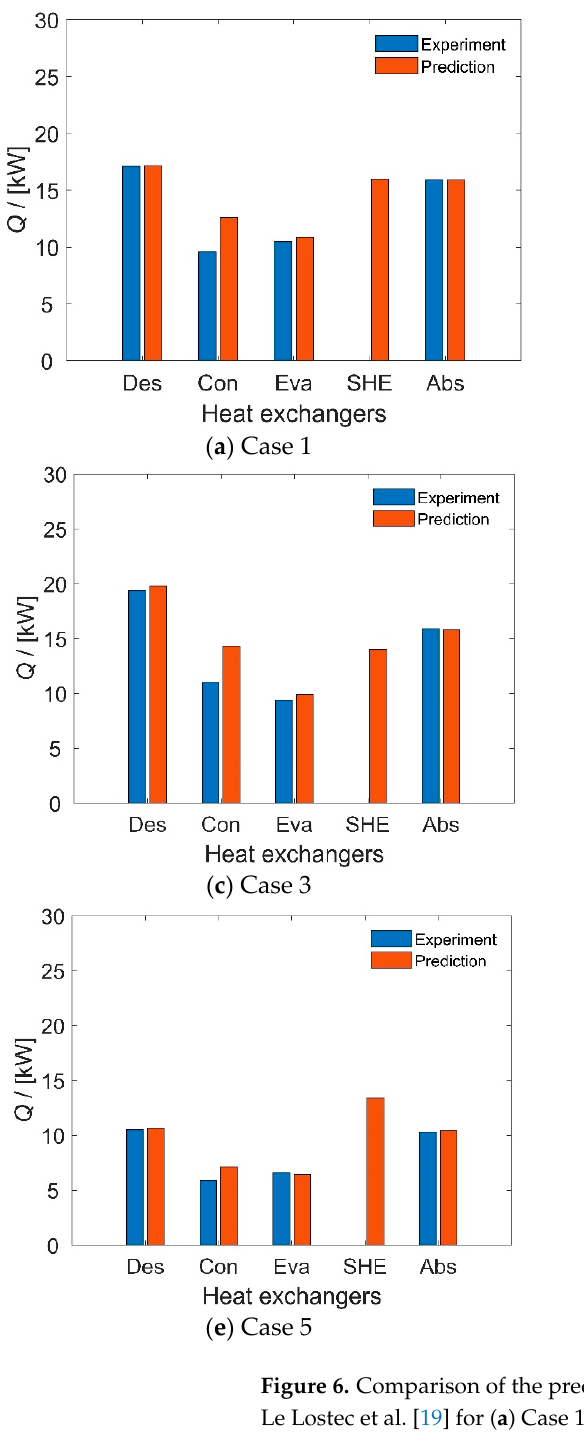
had a higher temperature.